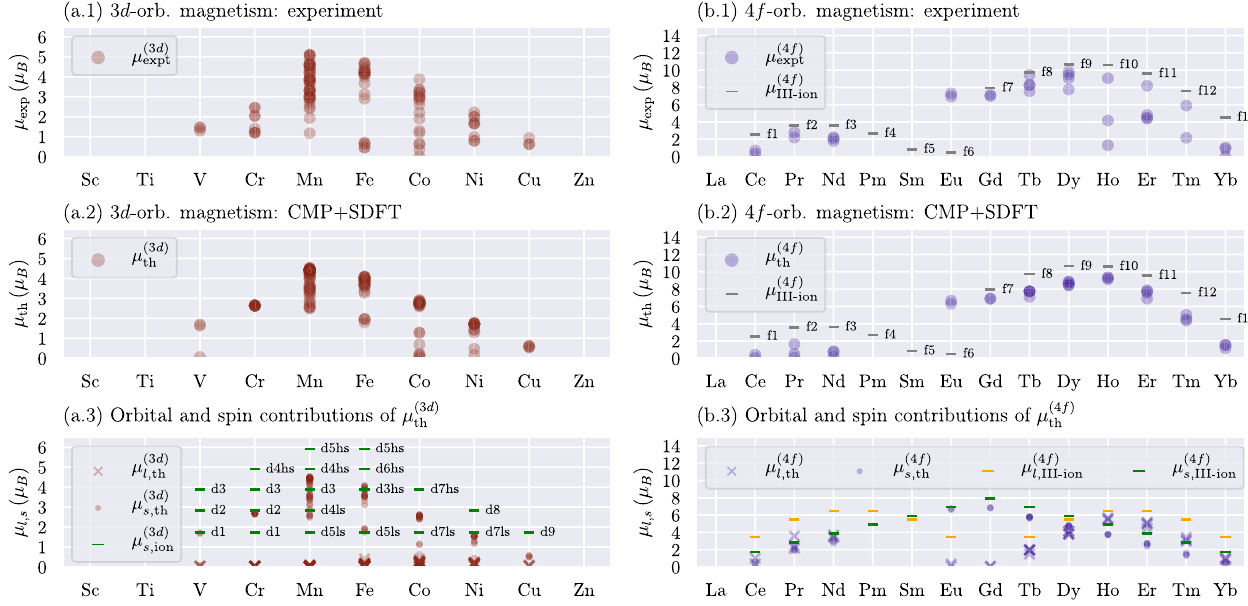
FIG. 5. The magnetic moment per site as a function of electrons per atom for 3 d - and 4 f -orbital magnetism. (a.1),(b.1) The experimental magnetic moment per site μ . (a.2),(b.2) The magnetic moment per site of the CMP þ SDFT minimum most similar to expt experiment with respect to its magnetic configuration μ . (a.3),(b.3) Absolute values of the orbital angular momentum contribution μ th and the spin contribution μ to μ s th